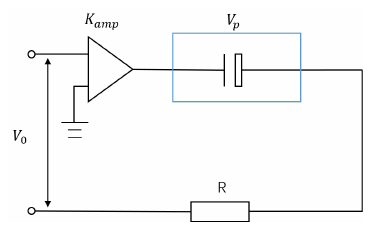
Figure 6. Drive circuit of the PZT stack.